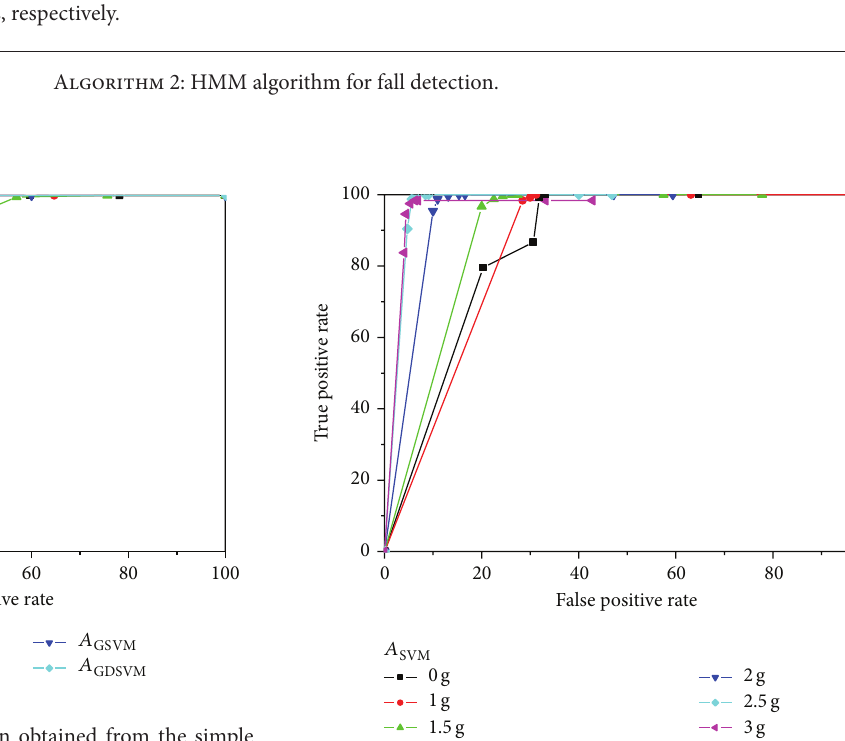
Figure 5: ROC curve of fall detection obtained from the simple and 𝜃 . threshold using the double fall-feature parameters of 𝐴 SVM The best fall detection is of sensitivity 98.75%, specificity 94.38%, = 2.5 g and 𝜃 = 65 ∘ . and accuracy 96.25% when 𝐴 SVM Table 1: Best fall and ADL detection results obtained from the = simple threshold method with the double threshold values 𝐴 SVM 2.5 g and 𝜃 = 55 ∘ (sensitivity = 100% and specificity = 91.56% and accuracy =